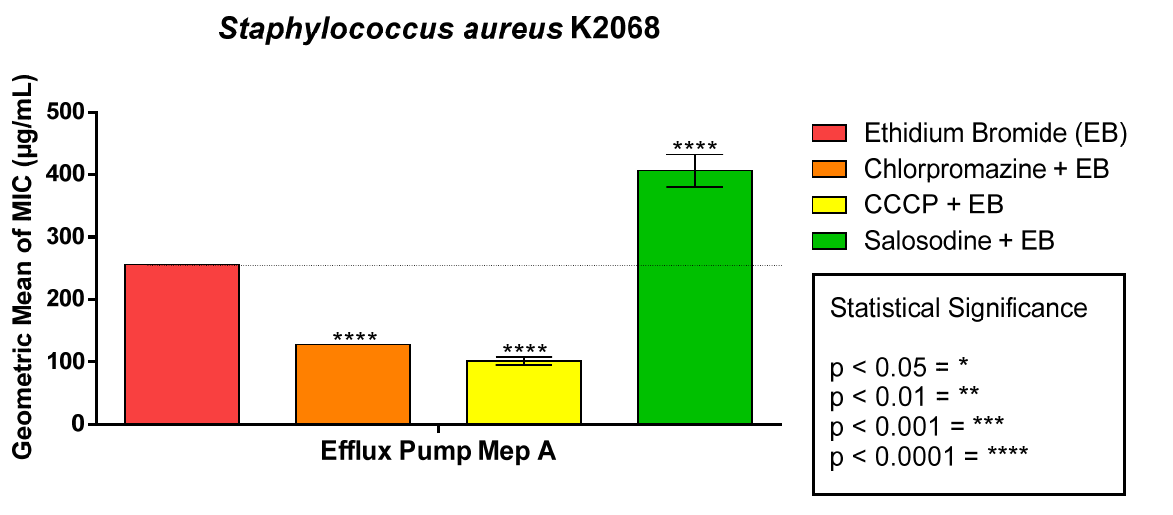
Figure 5. Modifying effect of ethidium bromide by solasodine on S. aureus strain K206B.